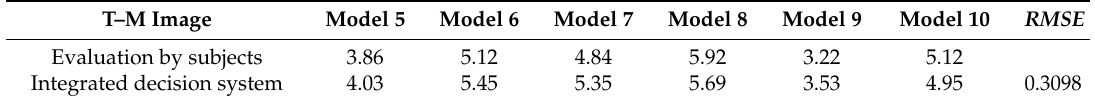
Table 8. RMSE result of the integrated decision system of train seat T–M image design.